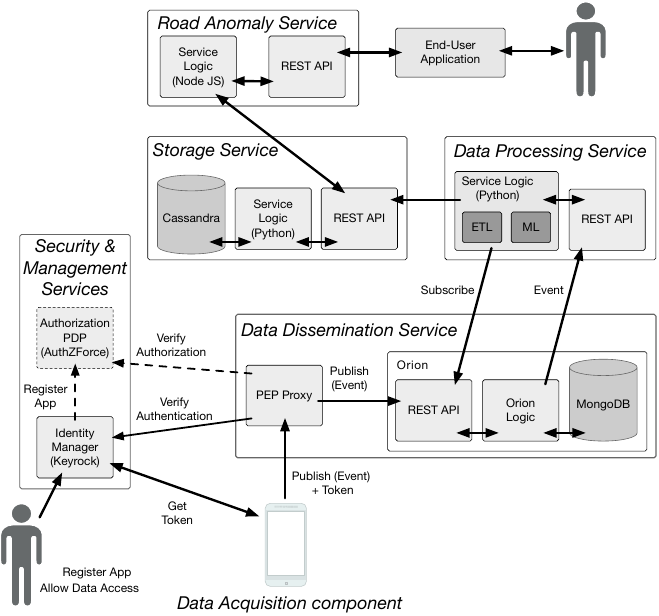
Figure 2. Road Anomaly Service